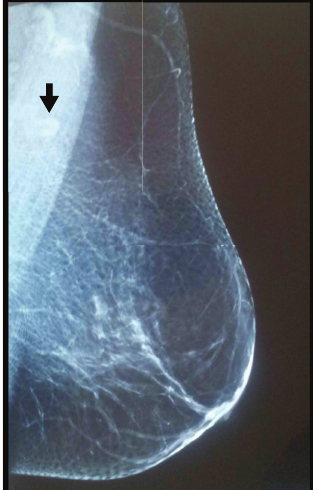
Figure 1: A mammography image with 18 × 10mm measured mass lesion that localized in the left axillary region; superposed to pectoral muscle and have irregular, indistinct margin.